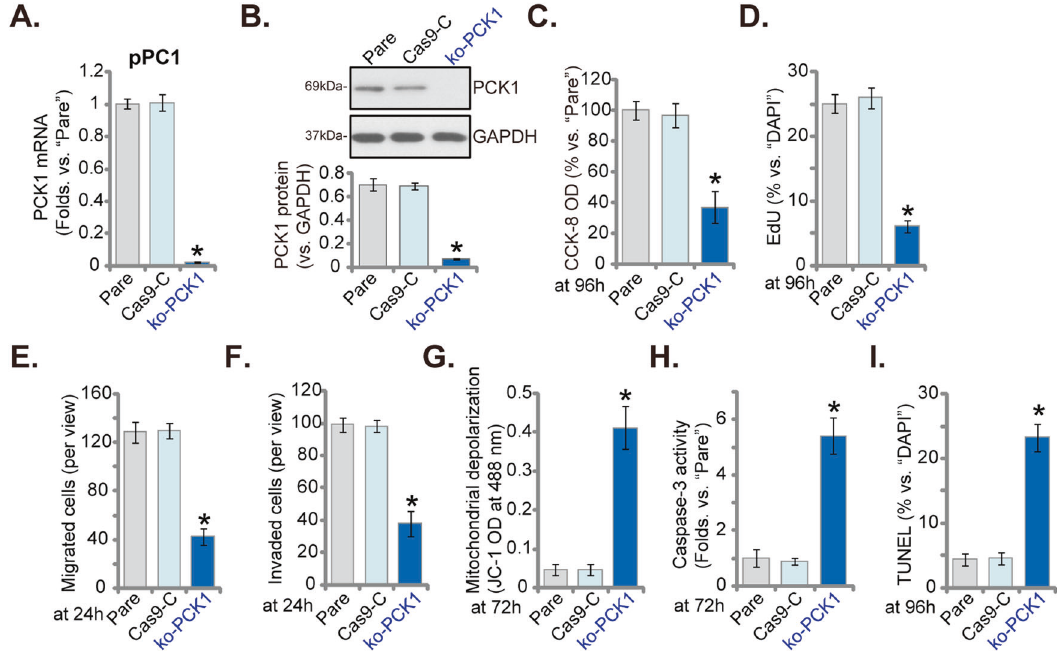
Fig. 4 CRISPR/Cas9-mediated PCK1 knockout inhibits pancreatic cancer cell growth and induces apoptosis activation. The single stable primary pancreatic cancer cells ( “ pPC1 ” ), bearing the lentiviral CRISPR/Cas9-PCK1-KO construct ( “ ko-PCK1 ” ) or the CRISPR/Cas9 control empty vector ( “ Cas9-C ” ), as well as the parental control cells ( “ Pare ” ), were established; Expression of PCK1 mRNA ( A ) and listed proteins ( B ) were tested. Cells were further cultured for applied time periods, cell viability ( C ), proliferation ( D ), migration, and invasion ( E , F ) were tested by the listed assays, with results quanti fi ed; Mitochondrial depolarization was tested by JC-1 intensity assay ( G ) and the caspase-3 activity was shown ( H ); Cell apoptosis was tested by nuclear TUNEL staining assays ( I ). Data were presented as mean ± standard deviation (SD, n = 5). * P < 0.05 vs. “ Cas9-C ” cells. The experiments were repeated fi ve times with similar results